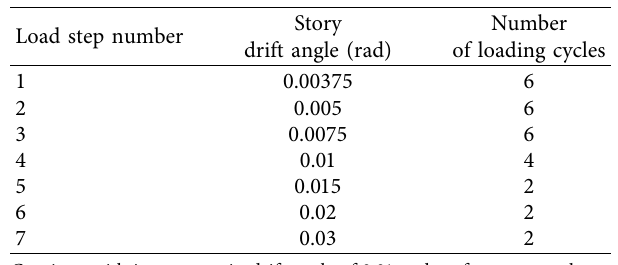
Table 3: FEMA/SAC2000 loading protocol in accordance with FEMA350 [20].